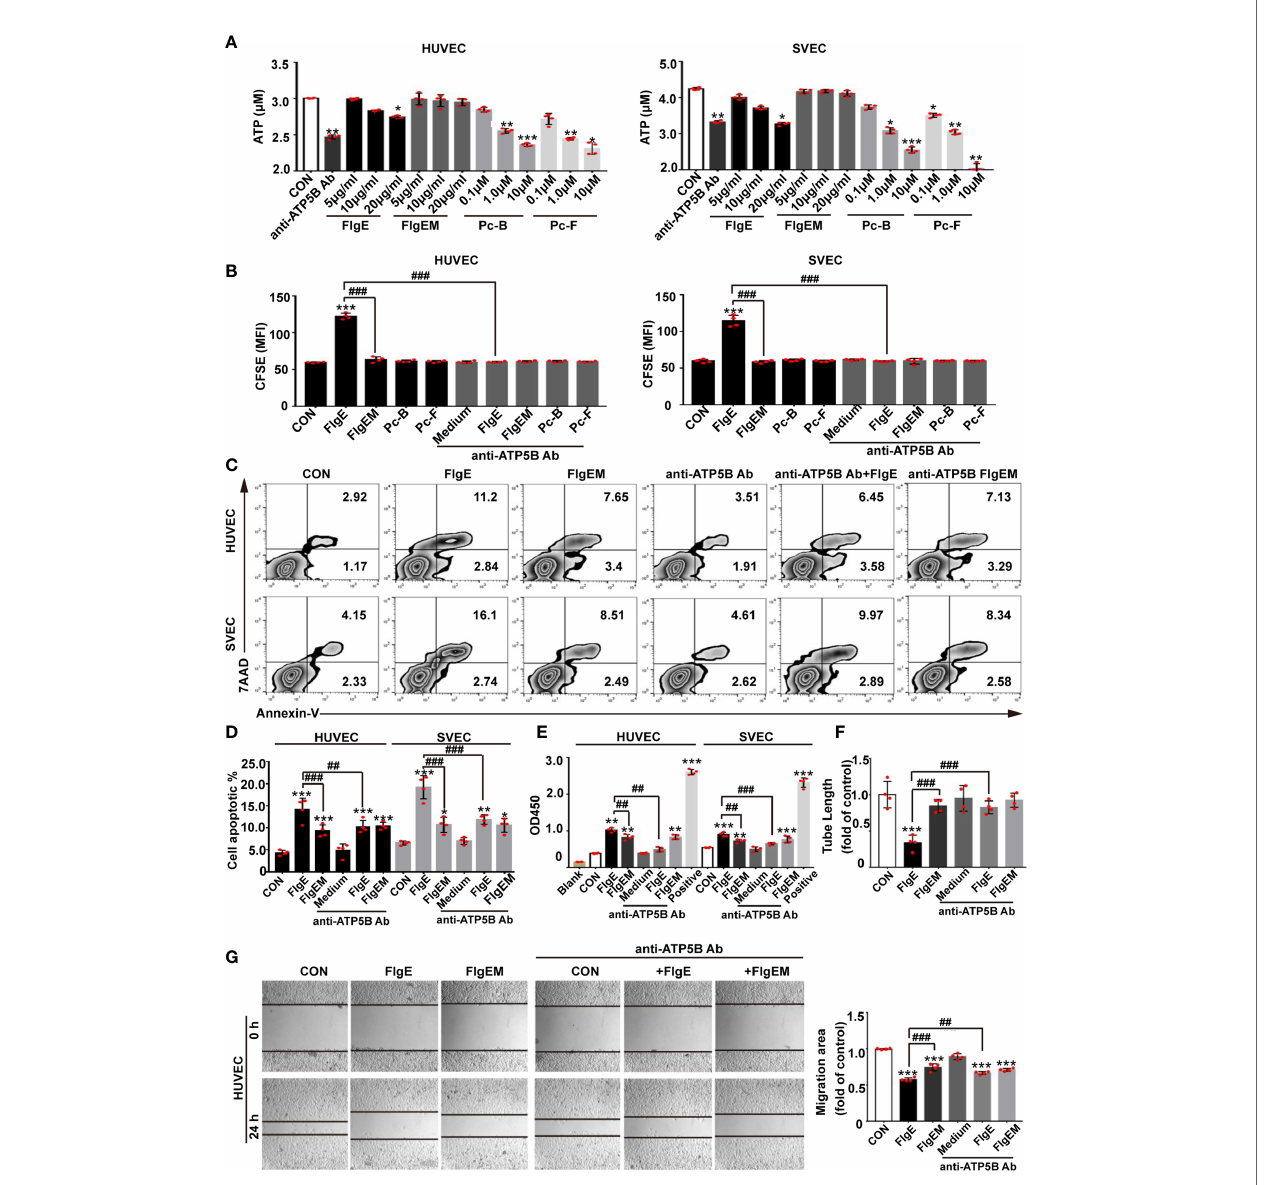
FIGURE 4 | Modulation of VECs behaviors by recombinant FlgE proteins was sensitive to anti-ATP5B interference. (A) Production of surface ATP catalyzed by ectoATP synthase. VECs were pretreated with anti-ATP5B antibodies (50 m g/ml), peptides (0.1, 1, and 10 m M), or FlgE/FlgEM proteins (5, 10, and 20 m g/ml) for 1 h, and ADP was added to 100 m M with 2 mM of Mg 2+ and 10 mM of P i . Medium was harvested 15 s later; and ATP contents (as re fl ected by relative luminescence unit (RLU)) were measured using an ATP assay kit. * p < 0.05; ** p < 0.01; *** p < 0.001 vs. control (CON), all by Dunnett ’ s test. (B – E) VECs were incubated with FlgE or FlgEM (both 20 m g/ml) and peptides Pc-B/Pc-F (both 100 m M) in the presence of anti-ATP5B antibodies (50 m g/ml) or not, for the indicated time length. Cell proliferation was determined by CFSE assay at 48 h, with higher mean fl uorescence intensity (MFI) indicating less proliferation of the whole cell population (B) , or cell death was measured at 4 h with fl ow cytometry ( C , with annexin-V staining for cell membrane change and 7AAD staining for nuclear DNA; D , statistics of samples in panel C ) or lactate dehydrogenase releasing assay ( E , as re fl ected by OD490; “ Positive ” represents a lactate dehydrogenase-releasing reagent supplied in the kit). (F) HUVECs were seeded into Matrigel-coated 96-well plates (2 × 10 4 cells/well) with different reagents (i.e., anti-ATP5B antibody 50 m g/ml, FlgE or FlgEM 10 m g/ml, or a combination). After 4 h of incubation, tube formations were observed under a microscope. Capillary-like tubes were traced, and total tube length of each group was calculated using ImageJ software. (G) HUVECs were grown in 24-well plates to con fl uence, switched to serum-free culture medium, and pretreated with anti- ATP5B antibodies (50 m g/ml) for 1 h; and then a scratch was made across the cell layer using a yellow tip. The cultures were rinsed, FlgE or FlgEM was added at 20 m g/ml in serum-free medium, the culture was continued for 8 h Images were captured under a microscope at the same sites of the scratches before and after the last 8-h incubation (left panel), and migration was quanti fi ed with ImageJ software. The migration potency under treatment was calculated as the ratio of migration distance to that in control groups (right panel). All experiments were repeated three times, and representative ones were shown. * p < 0.05, ** p < 0.01, *** p < 0.001 vs. control (CON). ## p < 0.01, ### p < 0.001 vs. FlgE, by two-way ANOVA test. VECs, vascular endothelial cells; CFSE, carboxy fl uorescein succinimidyl ester; HUVECs, human umbilical vein endothelial